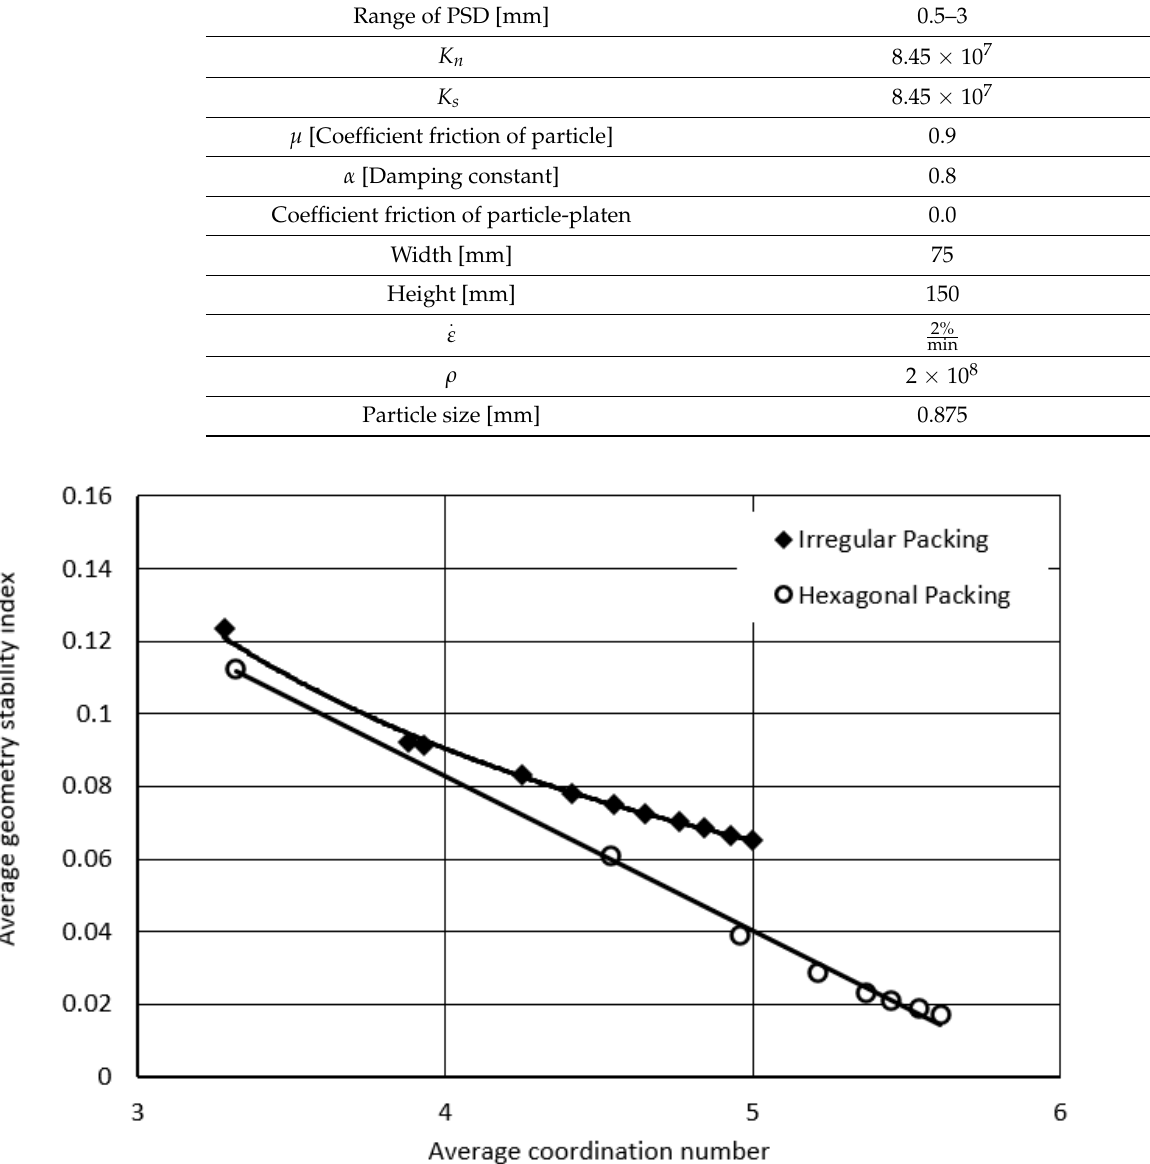
Figure 15. Average geometry stability index with average coordination number.